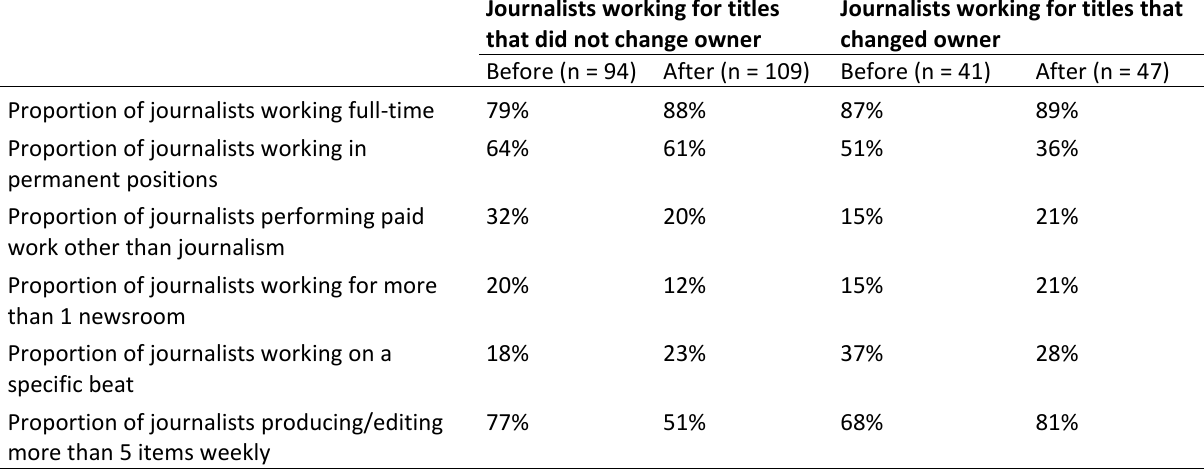
Table 1. The change of general working conditions of journalists before and after the media takeover in 2013. Journalists working for